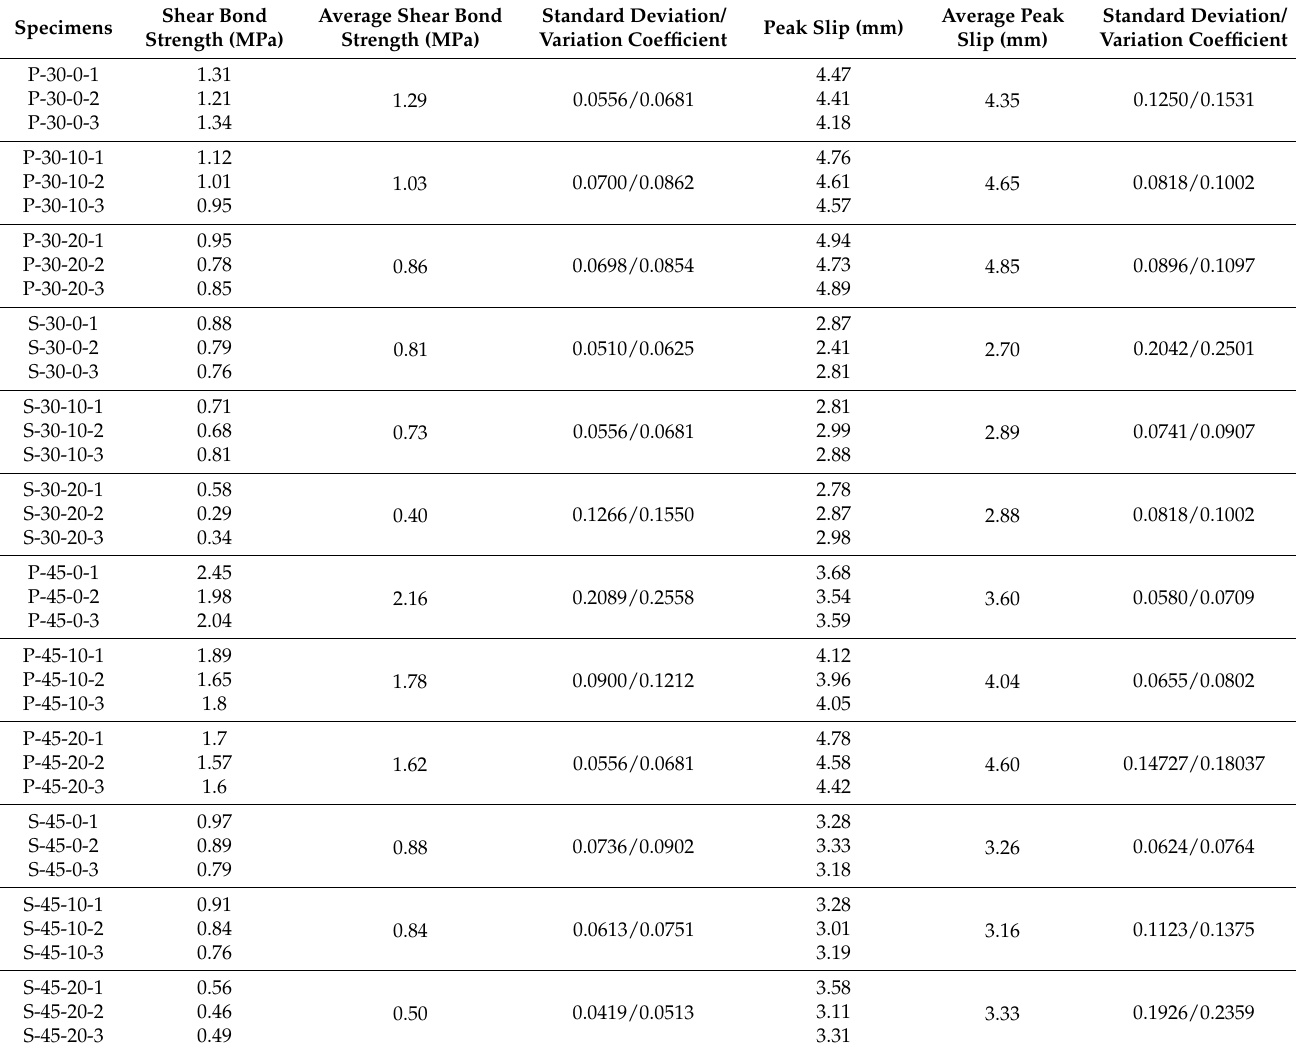
Table 4. Shear bond strength and peak slip of push-out